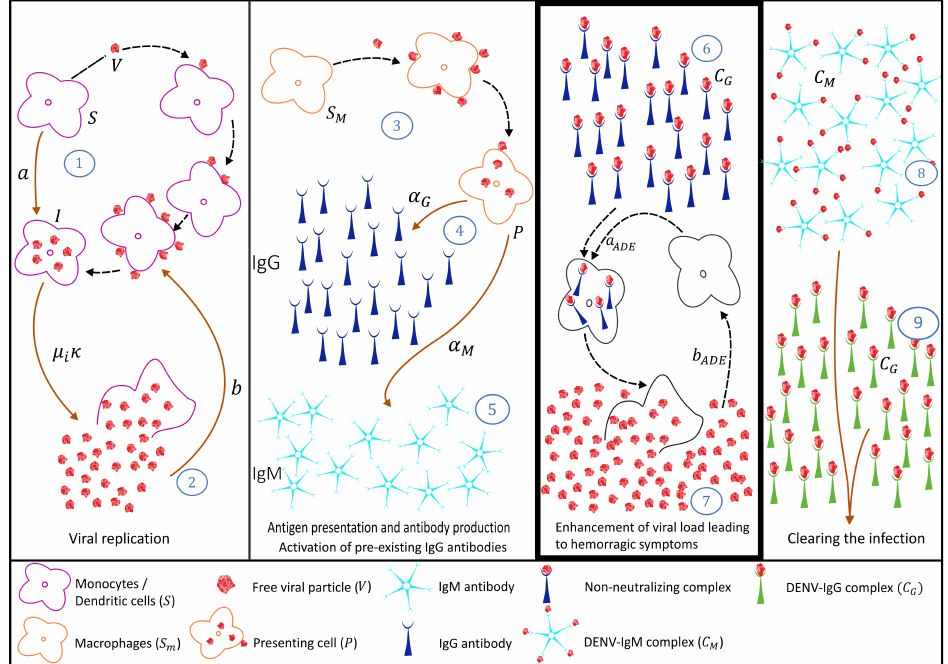
Figure 8. Schematic in-host dengue immunological responses mediated by antibodies: secondary infection with a different dengue serotype. Four blocks are used to describe 9 steps during the infection, from viral replication up to infection clearance, including disease augmentation via the ADE process (steps 6 and